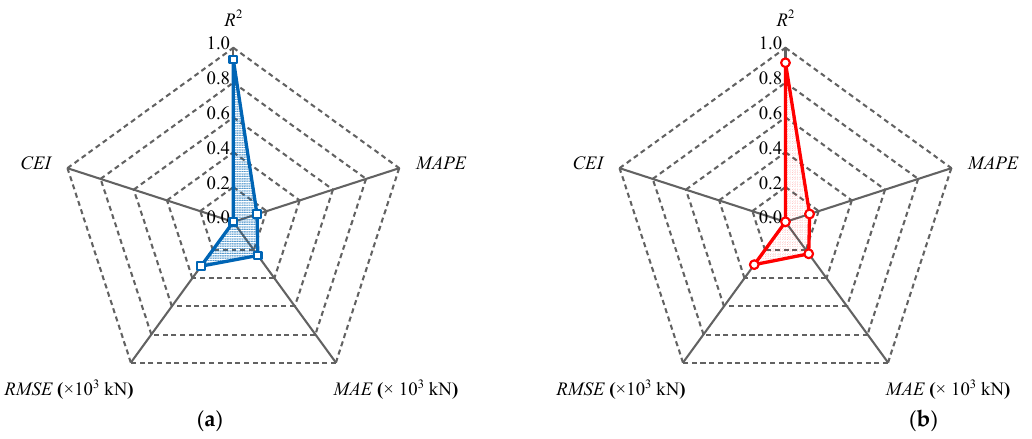
Figure 6. Radar chart of performance evaluation of PSVM in the ( a ) training set and ( b ) test set.